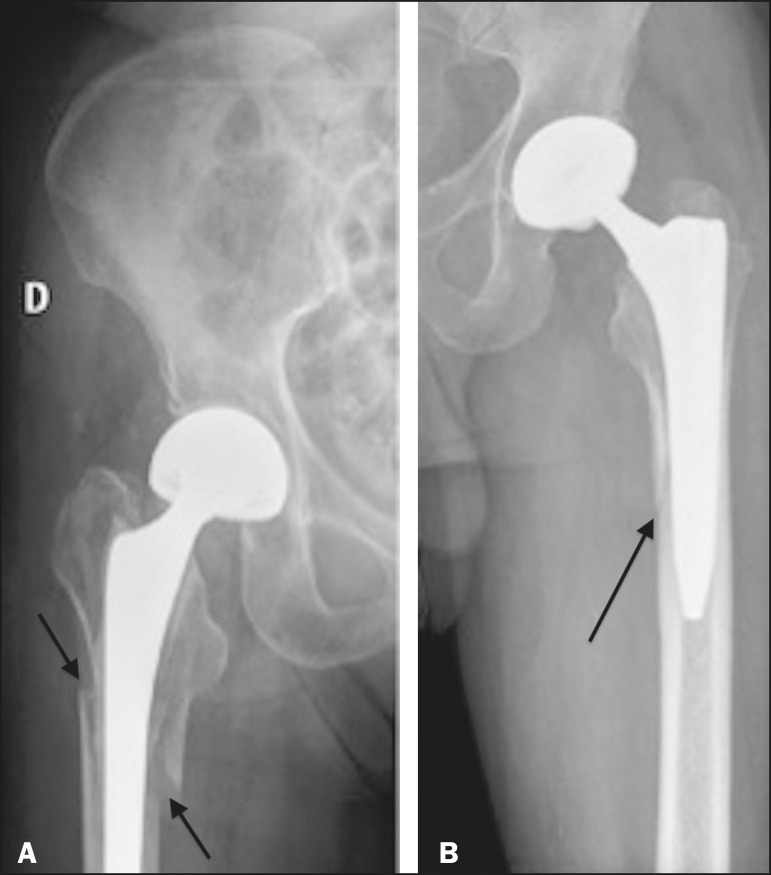
A: Anteroposterior X-ray of the right hip showing periprosthetic fracture (arrows) in the femoral component (Vancouver subtype B1). B: Anteroposterior X-ray of the left hip showing cortical fracture (arrow) at the medial margin of the femoral prosthetic component (Vancouver subtype B1).